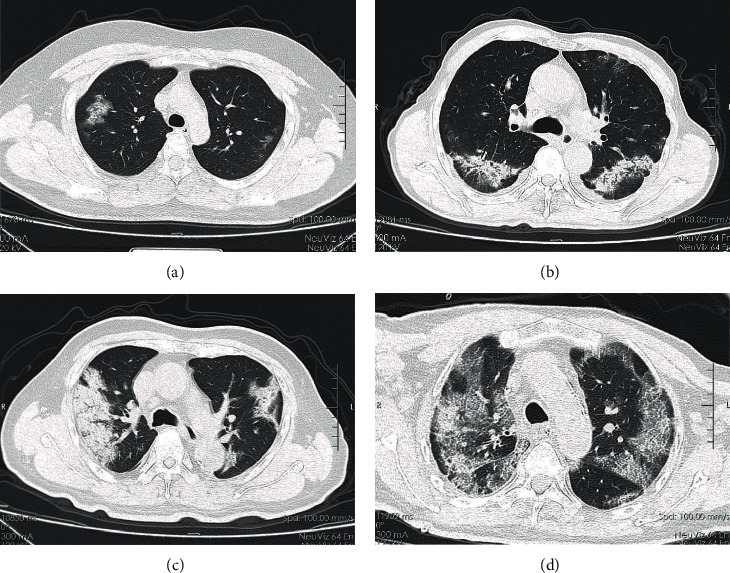
Typical CT images of the patients in three groups: (a) from euglycemia group; (b) from secondary hyperglycemia; (c, d) from diabetes group.